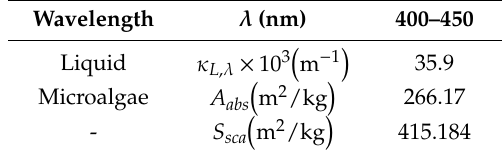
Table 1. The radiative characteristics of C. reinhardtii CC 125 cells and liquid phase.